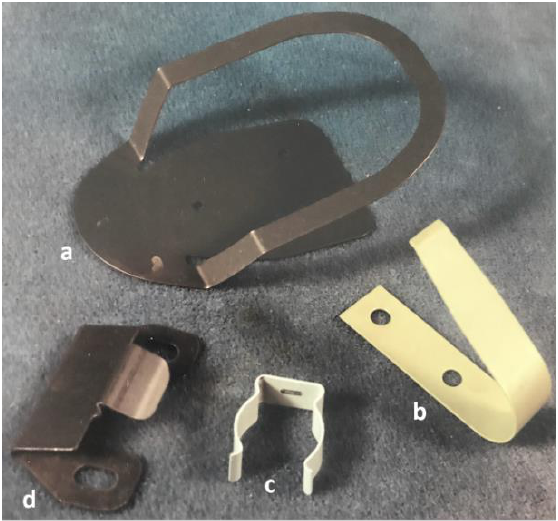
Figure 10. Miscellaneous components formed from Ti-15-3-3-3 sheet: ( a ) crew microphone holder (B-737/757); ( b ) access door clip; ( c ) tool clip); ( d ) interior window clip (B-747-400) [32].